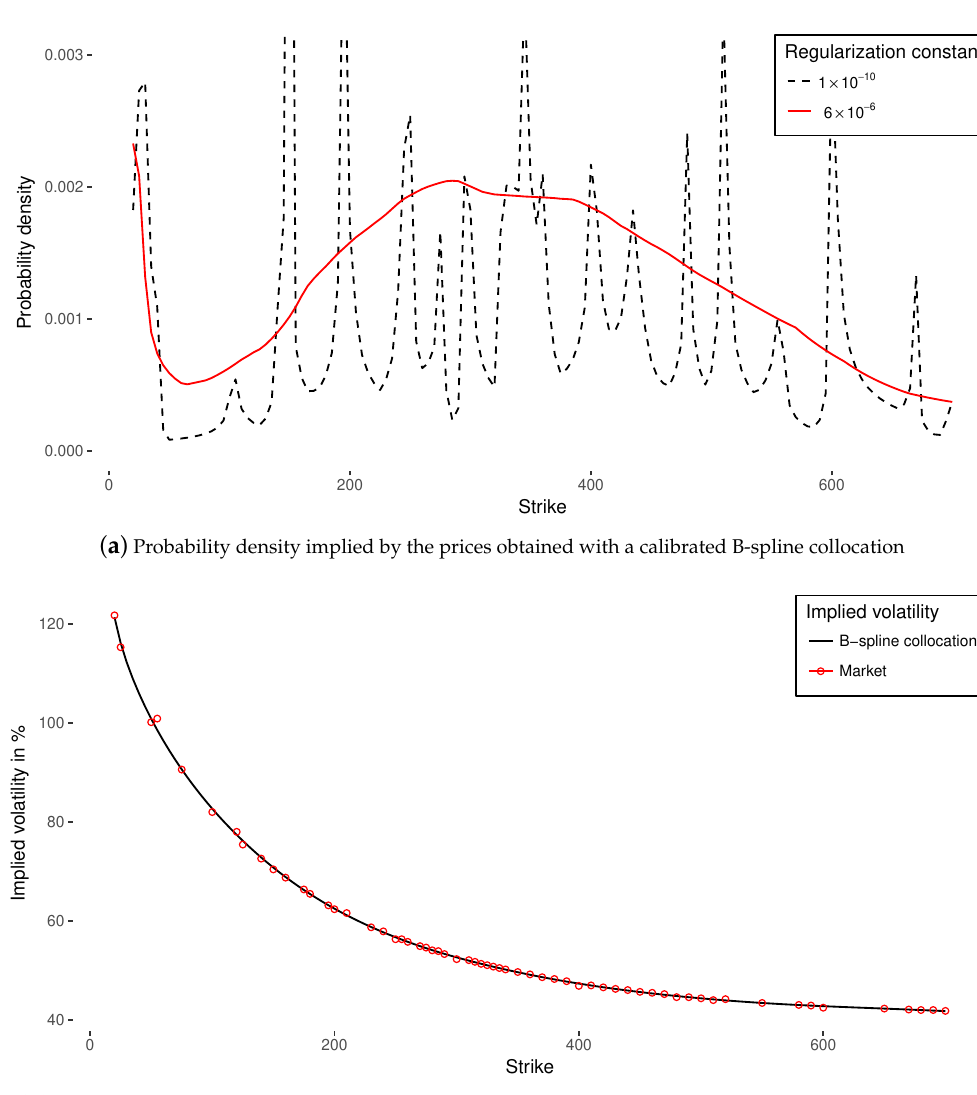
Figure 2. Implied probability density and implied volatility for the B-spline collocation, calibrated to 1 m TSLA